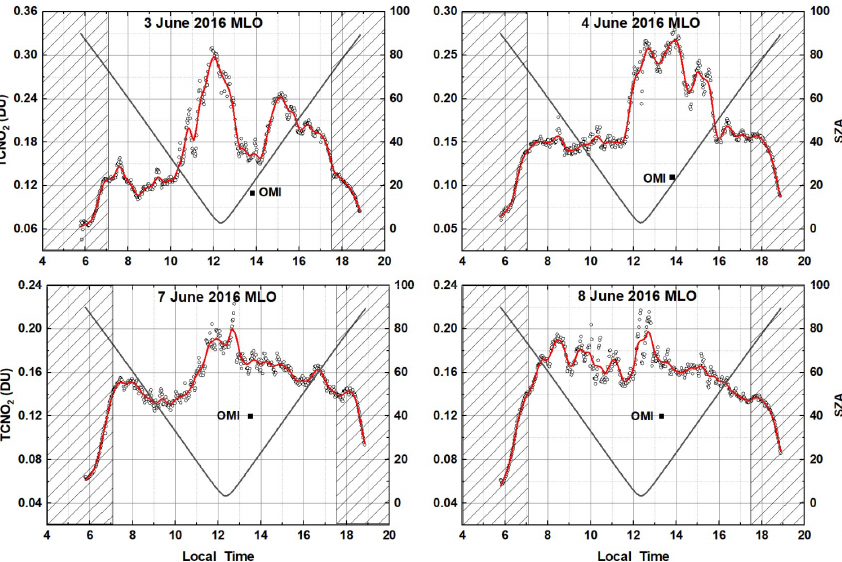
Figure A2. The diurnal variation of TCNO 2 at MLO on 4d during June 2016 compared to OMI TCNO 2 (small square). Shaded areas represent high SZA conditions where the PANDORA retrievals are not